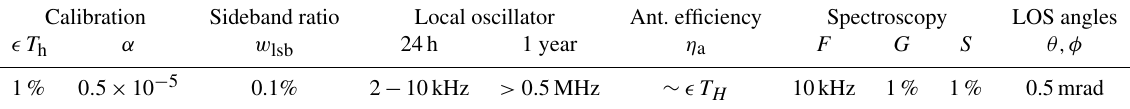
Table 2. Systematic errors in observational and forward model parameters: calibration hot-load temperature ( T h , Eq. 12) and radiance linearity assumption ( α , Eq. 11), sideband ratio ( w lsb , Eq. 1), local oscillator frequency ( ν lo , Eq. 1) over 24h and 1 year, antenna efficiency ( η a , Eq. 8), spectroscopic line center frequency ( F ), pressure broadening ( G ) and strength ( S ) and LOS azimuth and elevation angles ( θ,φ ,